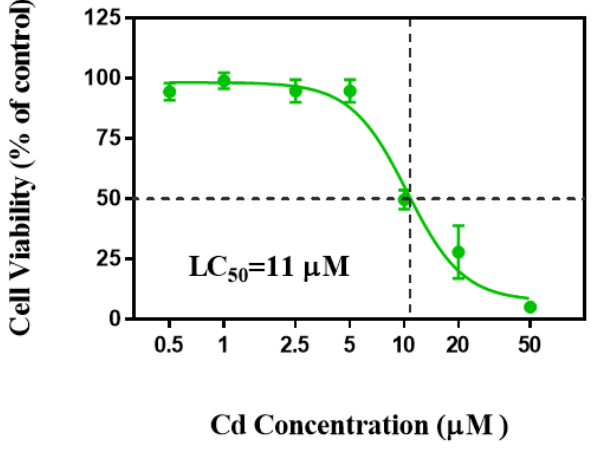
Figure 1. Cell viability of HaCaTs after exposure to Cd for 24 h. The 50% lethal concentration (LC 50 ) of Cd was calculated through a nonlinear regression curve (log (inhibitor) vs. normalized response − variable slope).